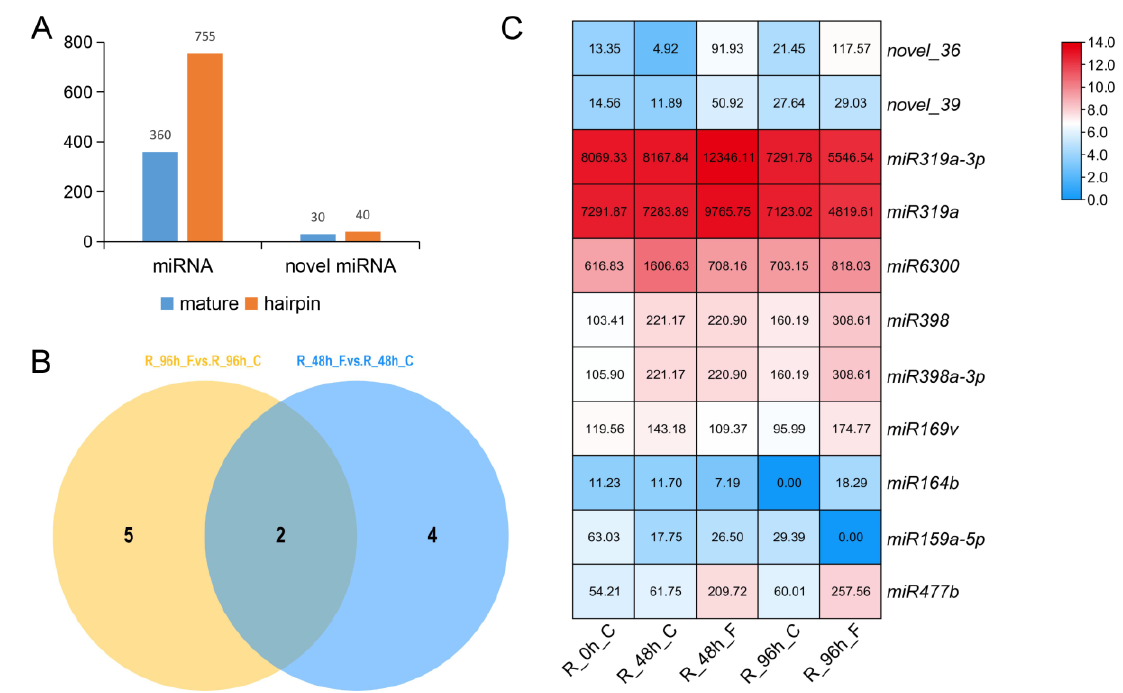
Figure 1. Identification of differentially expressed miRNAs (DEMs) responsive to FW in cucumber. ( A ) Distribution of known and novel cucumber miRNAs, including mature and hairpin miRNAs; ( B ) Venn diagram of the DEMs between the Foc-inoculated cucumber roots and the mock-inoculated control roots at 48 and 96 h post-inoculation; ( C ) Heatmap analysis of the DEMs among different sequencing libraries. Red and blue indicate up-regulated and down-regulated expression, respectively.